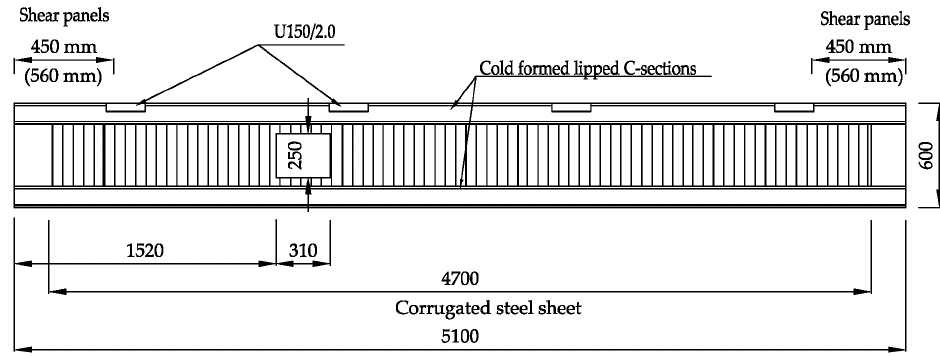
Figure 2. Configuration of the tested built-up beam with web openings (aspect ratio h wo /b wo = 0.8) assembled by spot welding.